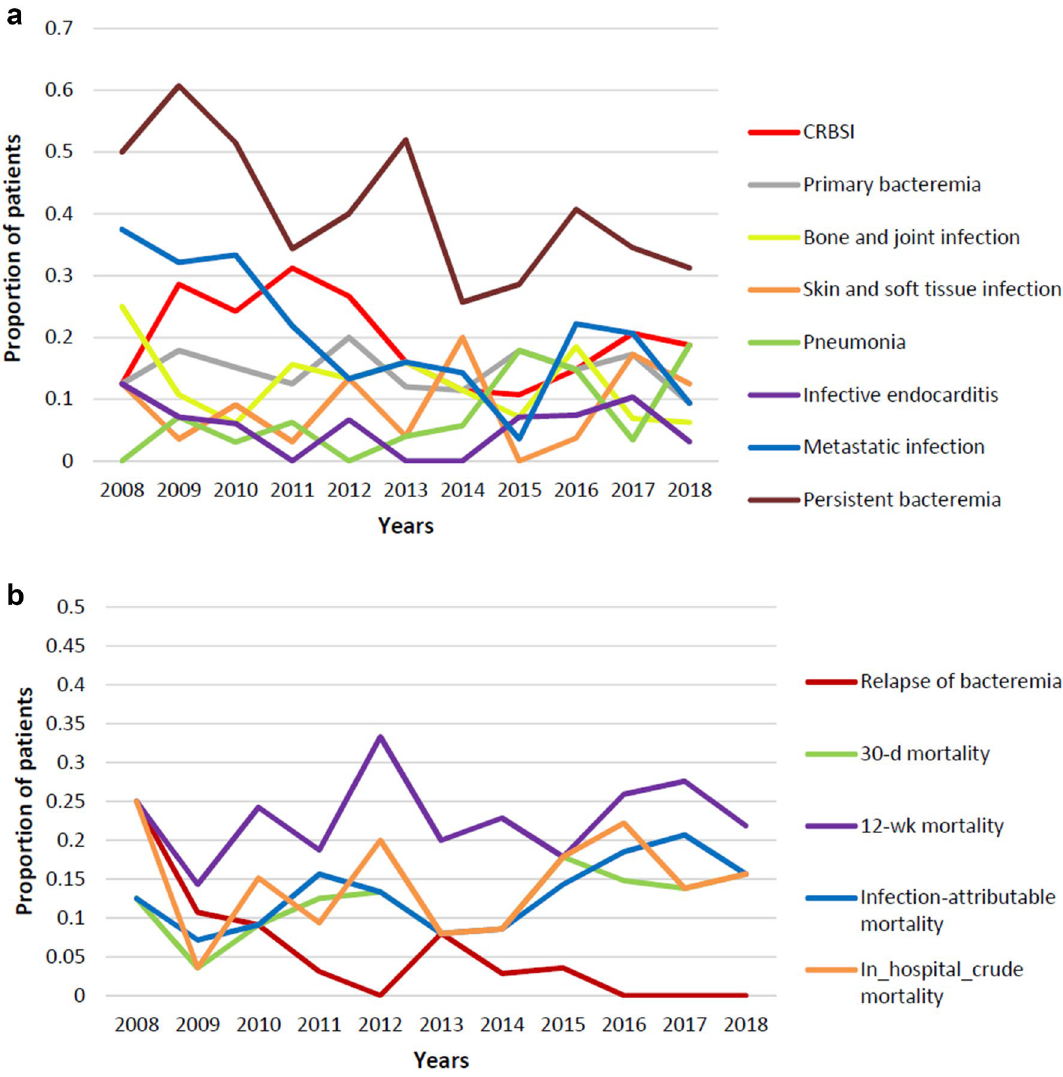
Figure 2. ( a ) Clinical characteristics of ST72 MRSA bacteremia over the study period. ( b ) Clinical outcomes of ST72 MRSA bacteremia over the study period. CRBSI, catheter-related blood stream